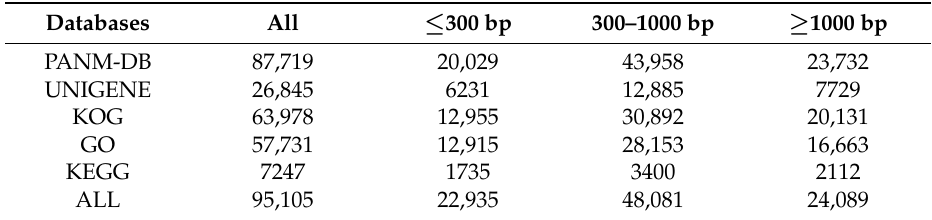
Table 2. Annotation of T. longicaudatus assembled unigene sequences against public databases.